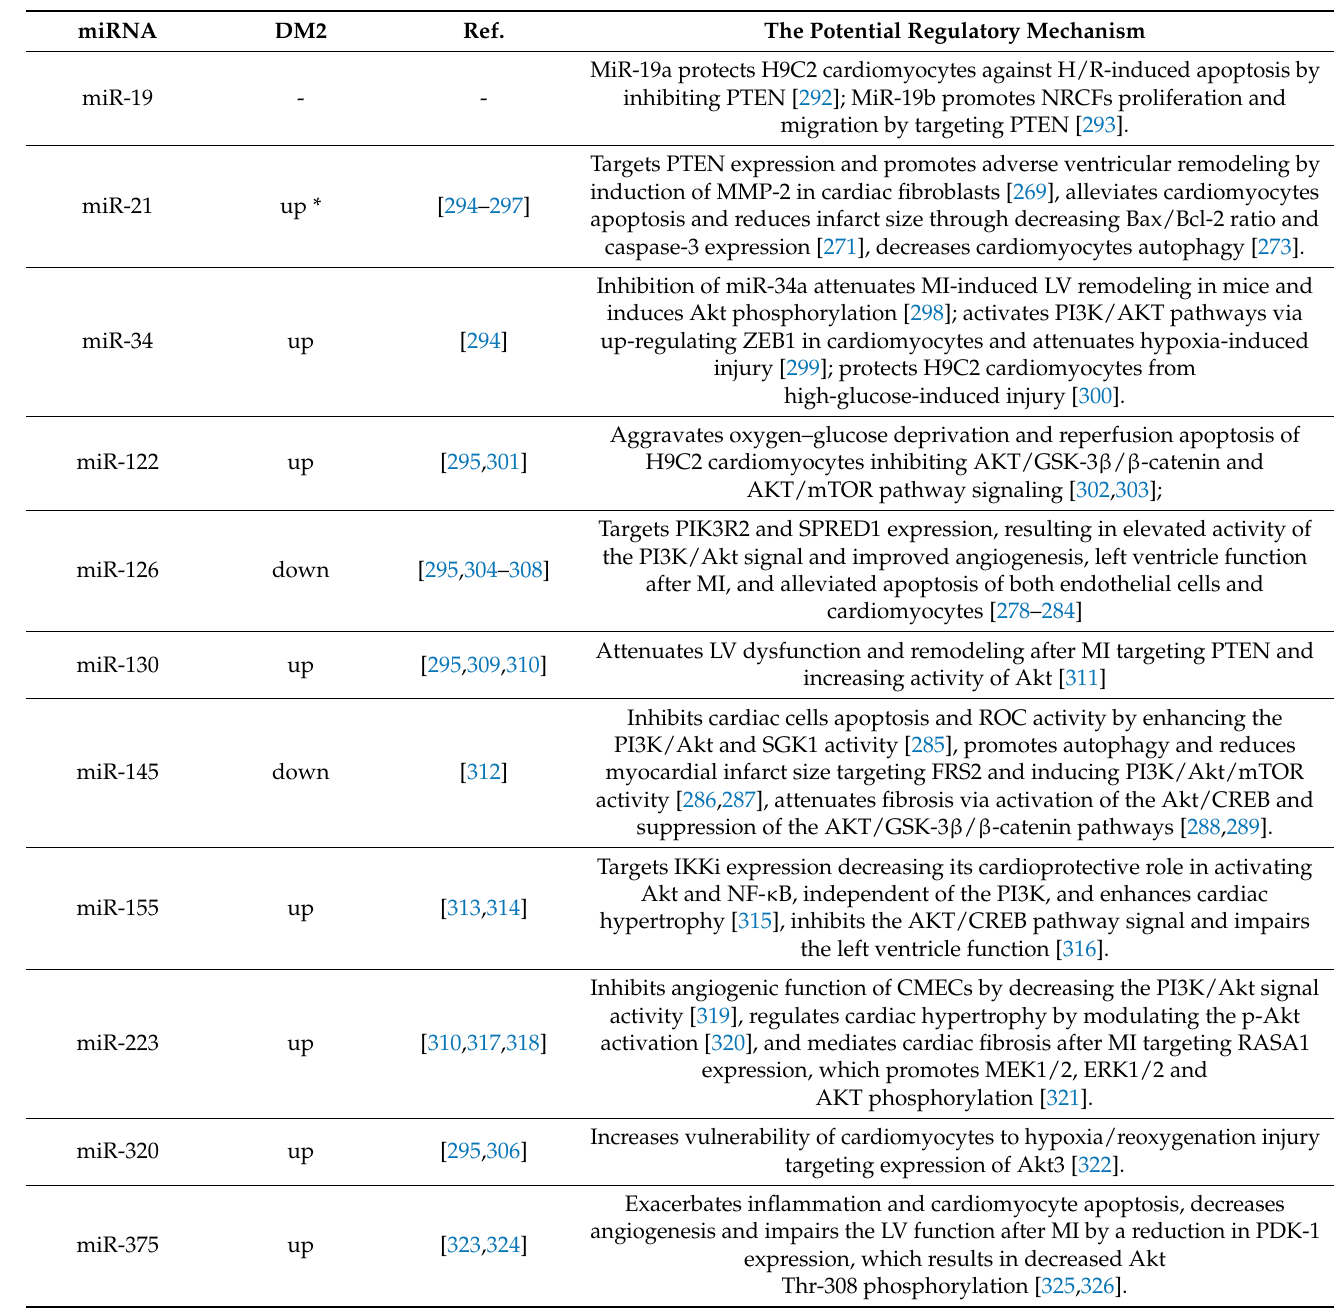
Table 1. A list of microRNAs which can impair PI3K/Akt signal activity and potential mechanisms of their impact on ischemia–reperfusion injury and post-infarction remodeling. The Potential Regulatory